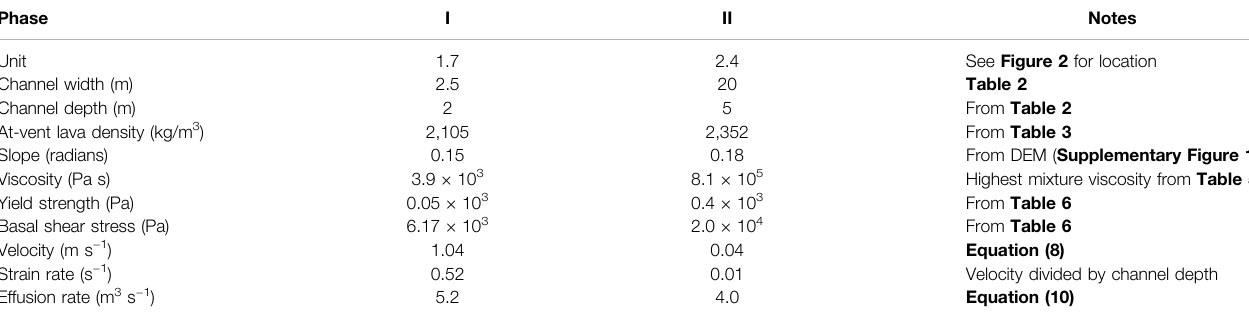
TABLE 7 | At-vent dimensional, rheological and dynamic parameters for the master channels feeding Units 1.7 and 2.4. Phase I